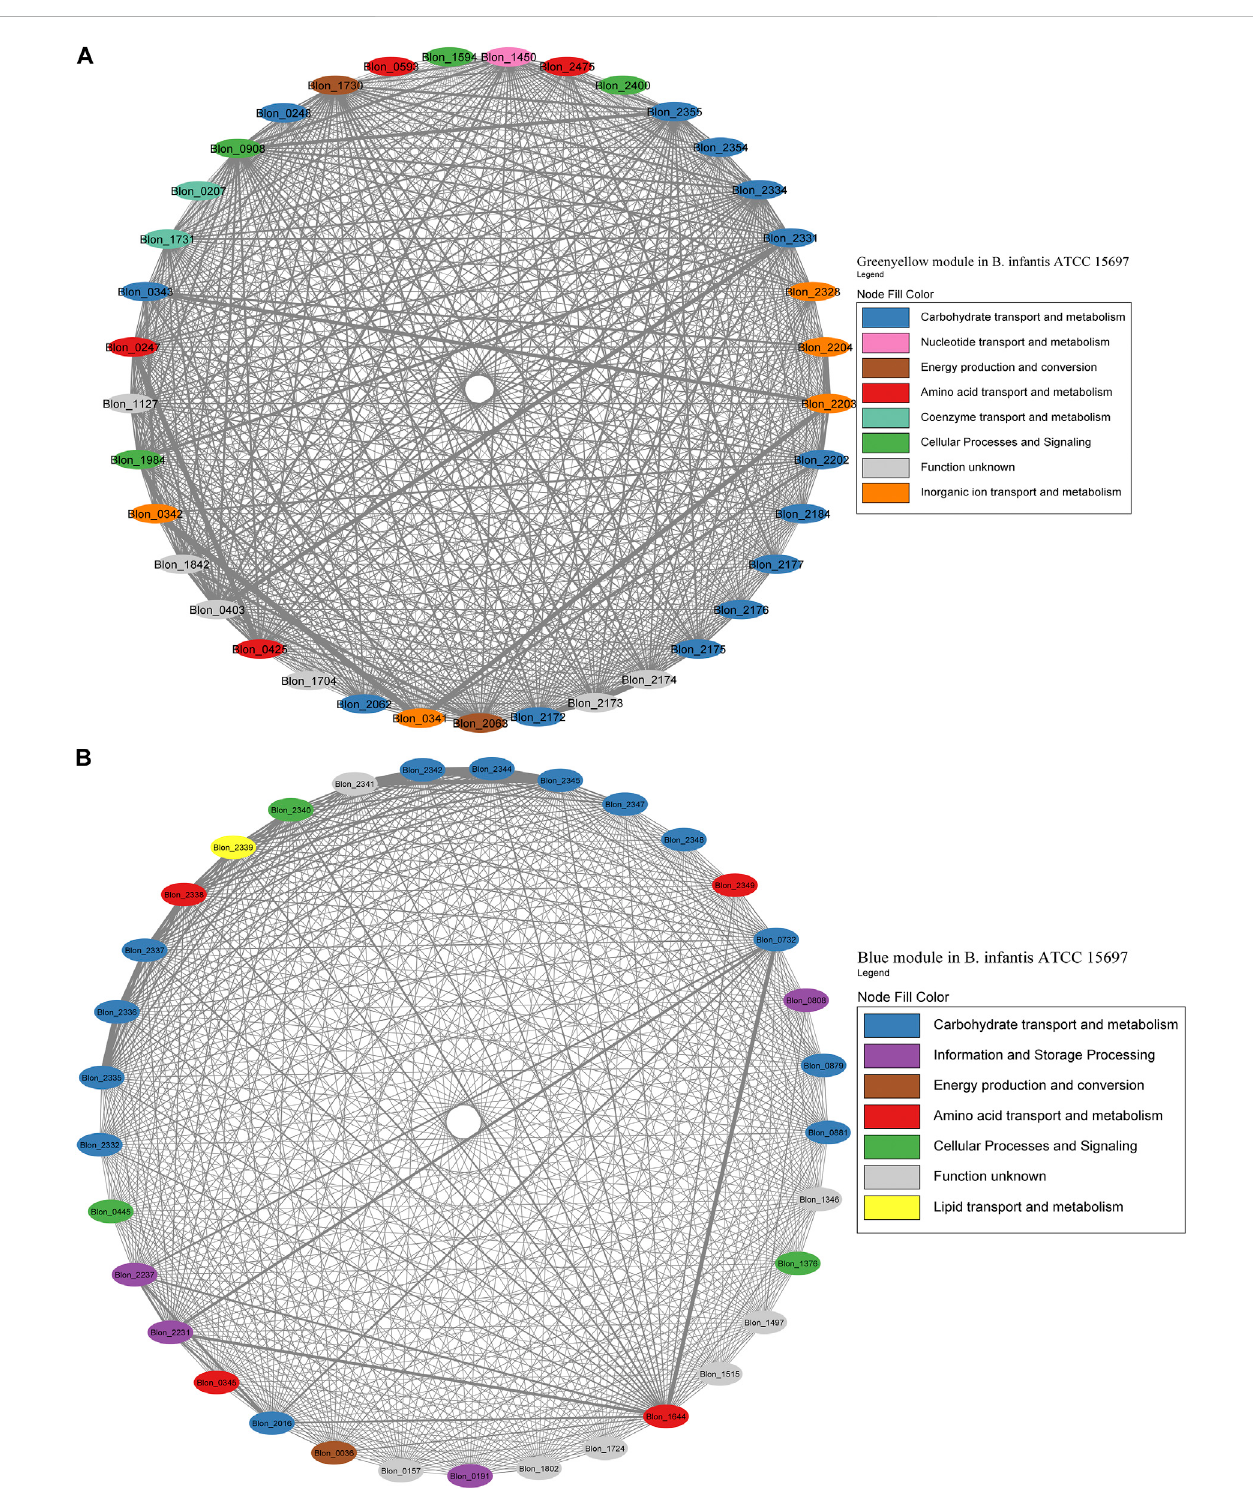
FIGURE 7 HMO-related co-expression networks in B. infantis . (A) Greenyellow and (B) Blue module in for B. infantis . All Network construction consisted of modulesweremanuallyanalyzed,andthosecontainingHMO-metabolizinggeneswereusedtocreateaco-expression network.Thisanalysisconsideredthe neighboring genes of each node with the highest